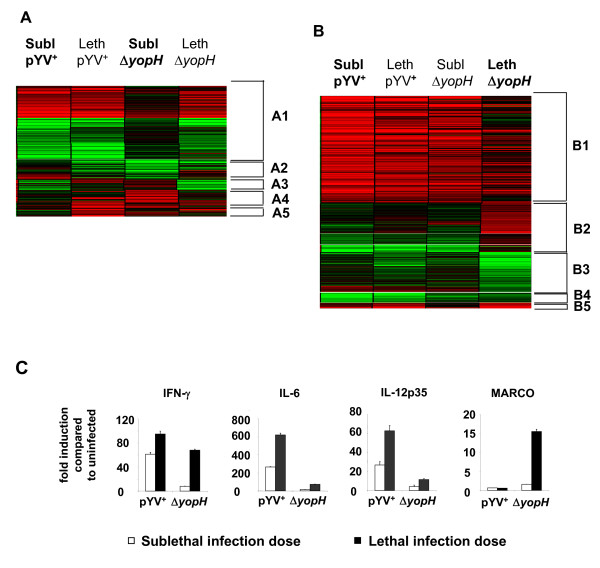
Comparison of gene expression between mice infected with pYV+ and ΔyopH. Microarray analysis of CD11b+ cells isolated from spleen of mice infected with pYV+ or ΔyopH for one day. All probe sets are displayed whose SLR ratio between infection with pYV+ and ΔyopH for one day was > 1.49 or < -1.49. Heat maps indicate increased (red) or decreased (green) expression of genes in CD11b+ cells one day after infection of mice compared to CD11b+ cells from uninfected mice. The heatmaps indicate genes differentially expressed and clustered in different groups: (A, approach I) sublethal pYV+ infection versus sublethal ΔyopH infection; (B, approach II) sublethal pYV+ versus lethal ΔyopH infection. (C) CD11b+ cells were enriched from uninfected mice and from mice infected for 1 day with pYV+ or ΔyopH, and RNA was extracted. mRNA expression of IFN-γ, IL-6, IL-12p35 and MARCO was analysed and normalized to RPL8 mRNA expression. The data represent the fold induction of mRNA expression compared to CD11b+ cells from uninfected mice. Representative data for three independent experiments are shown.